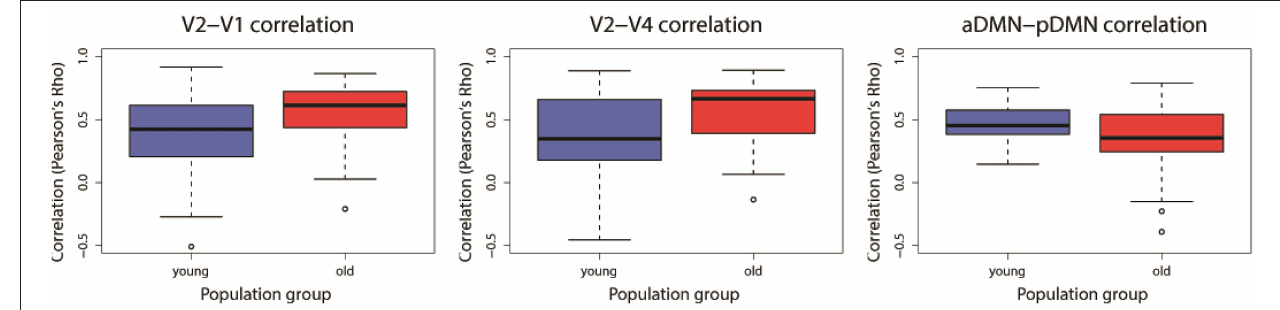
FIGURE 5 | Significant differences found for three component-pairs: [V2–V1], [V2–V4], and [aDMN–pDMN]. Blue denotes the young adults and Red represents the older adults. Component-pairs V2–V1 and V2–V4 demonstrated an increase of the between-network correlation with age, while the aDMN–pDMN demonstrated a reduction of its between-network correlation. ( V1, visual area 1 component; V2, visual area 2 component; V4, visual area 4 component; aDMN, anterior DMN component; pDMN, posterior DMN component) .